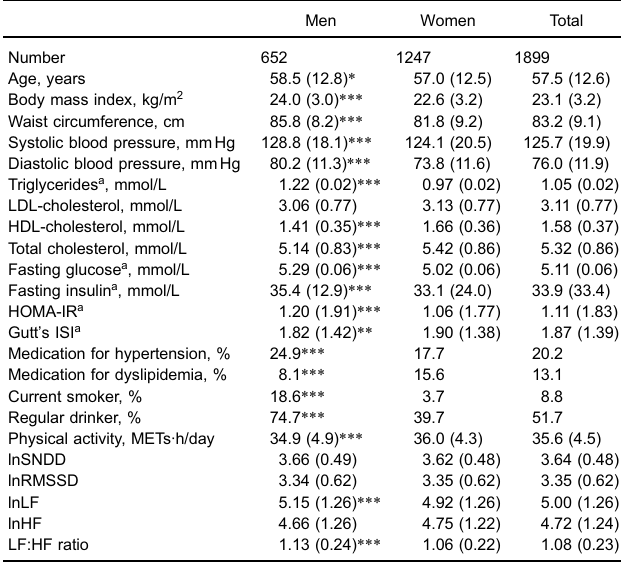
Table 1. Population characteristics in the Toon Health Study